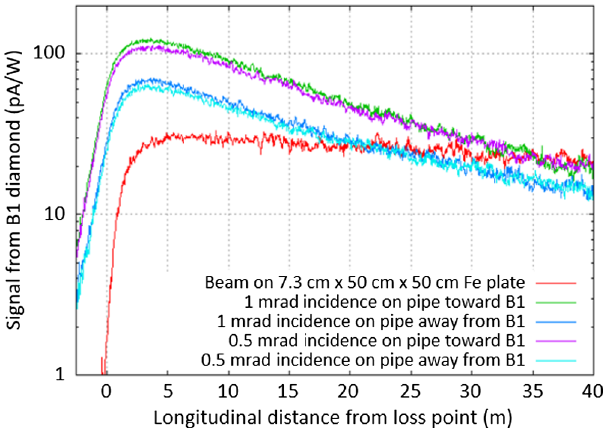
FIG. 9. Simulated current (pA) from a B1 diamond placed 2 m transversely from the beam pipe, as a function of the longitudinal distance from a 1-W beam loss on a protection collimator (red line) or from glancing incidence on a 1.5-mm-thick stainless-steel beam pipe.